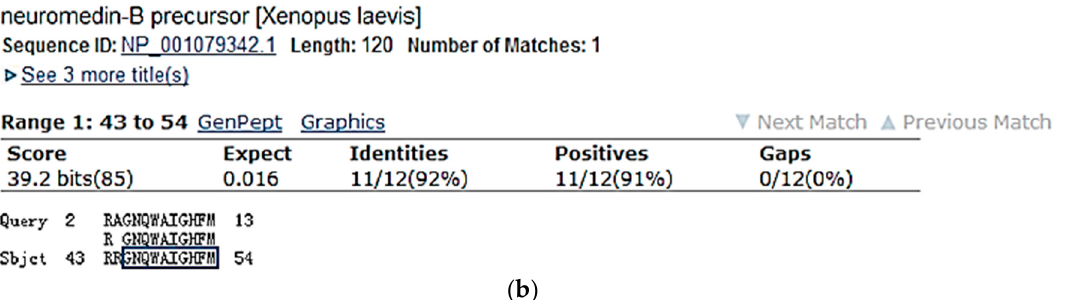
Figure 3. National Centre for Biotechnology Information-Basic Local Alignment Search Tool Protein Database (NCBI-BLASTp) analysis of the mature peptide amino acid sequence of ranatensin-HL. ( a ) Ranatensin-HL and bombesin precursor ( Rana catesbeiana ) amino acids 46–58 showing 100% identity. (Accession number: ACO51610.1); ( b ) Ranatensin-HL and neuromedin-B precursor ( Xenopus laevis ) amino acids 43–54 showing 92% identity (Accession number: NP 001079342.1); however, the C-terminal 10-amino acid of ranatensin-HL and the putative mature neuromedin-B peptide [22] showed 100% identity. The predicted mature peptide domain is boxed.